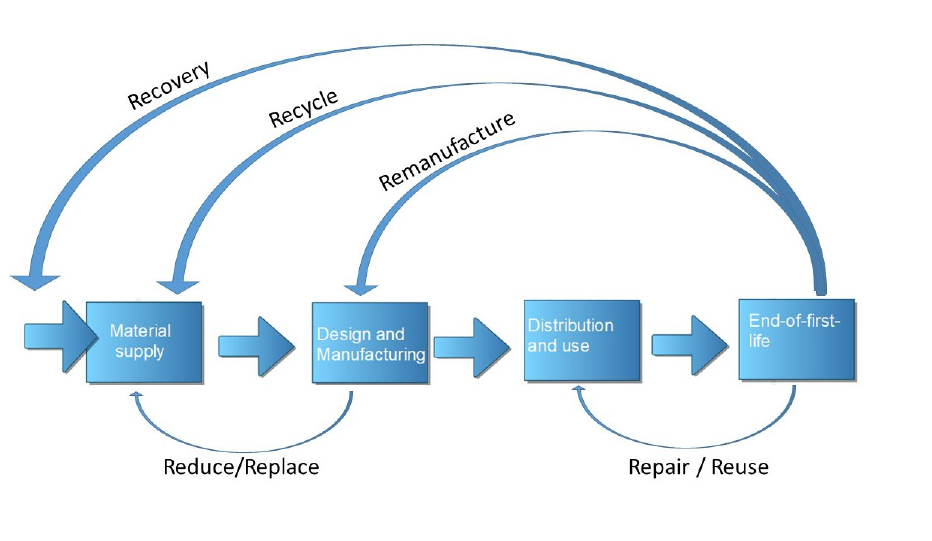
Figure 1. Comparison between circular and linear economy models